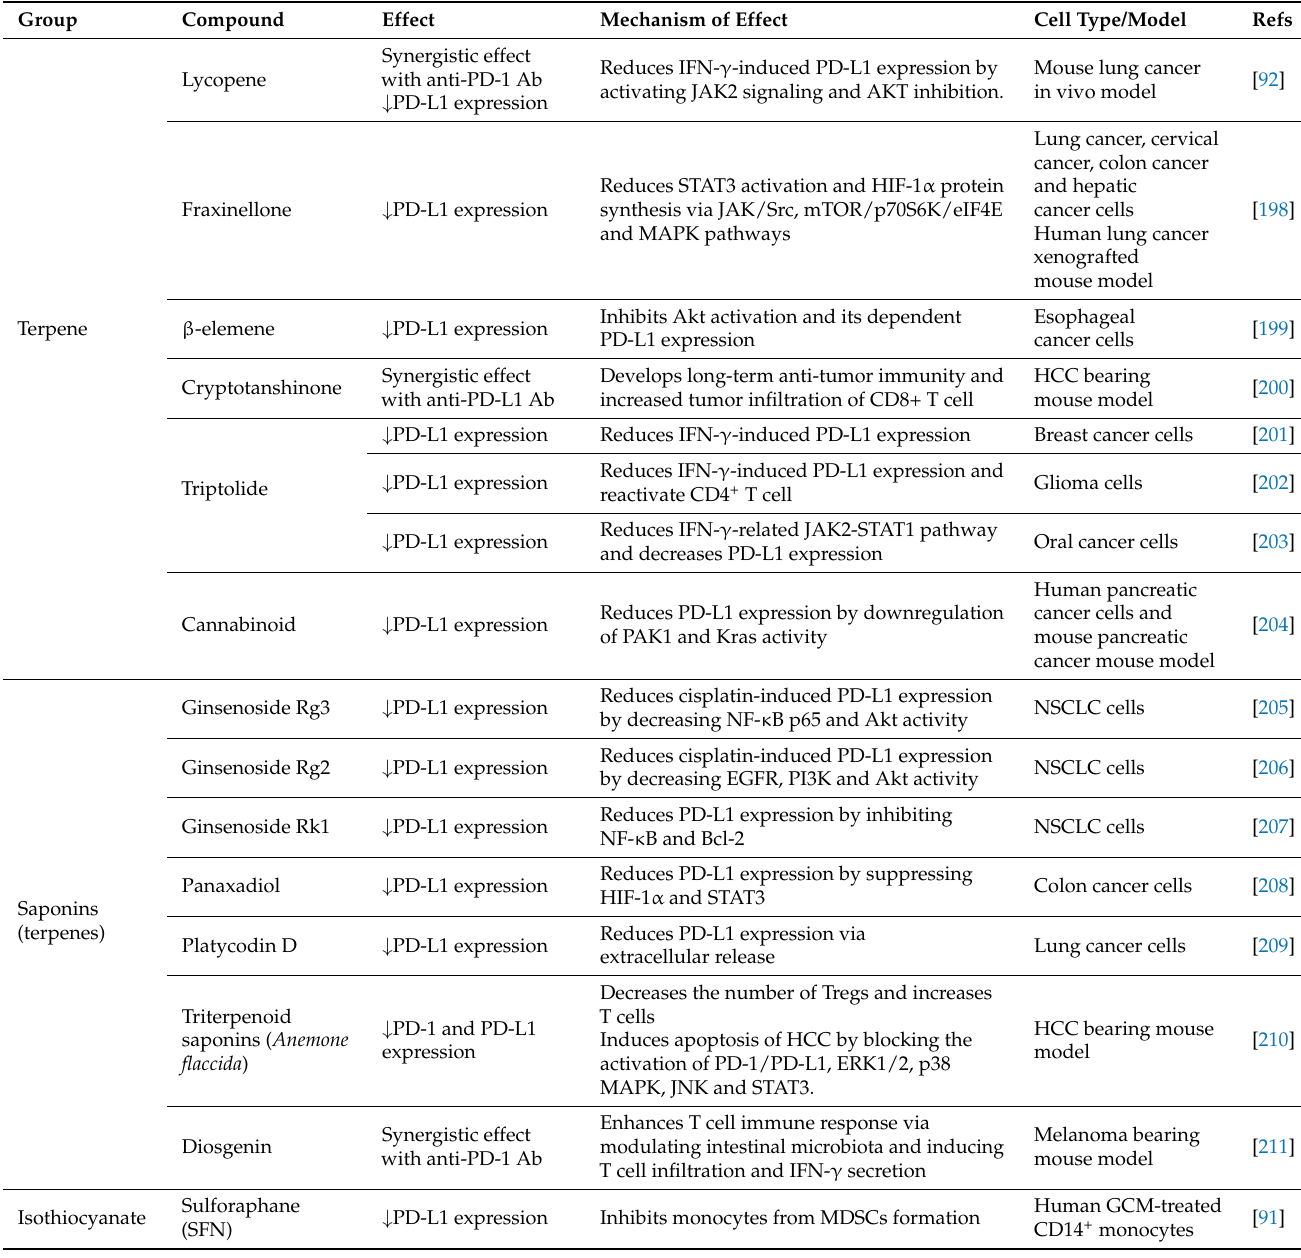
Table 2. List of non-polyphenolic compounds and their effects with mechanisms on immune checkpoints modulation.